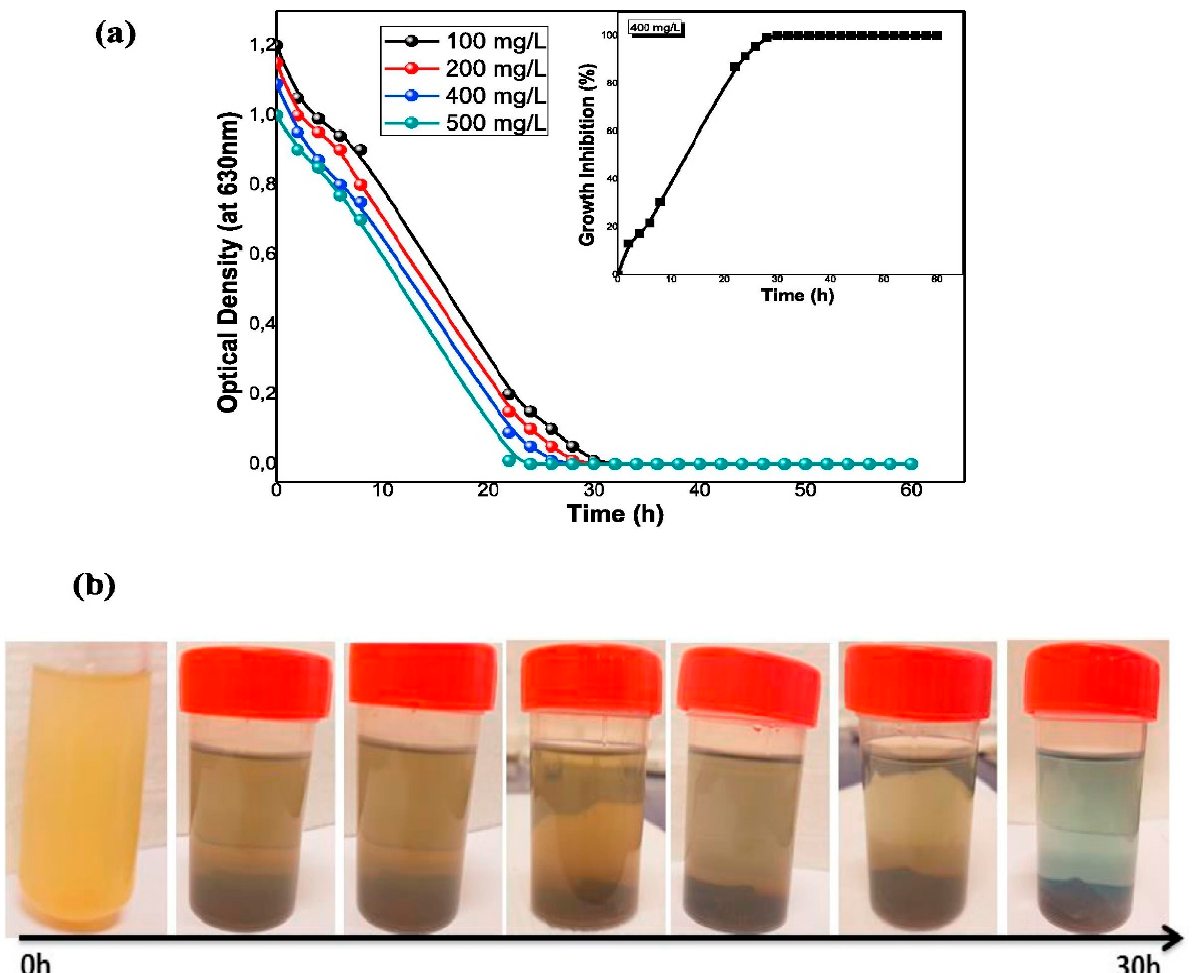
Figure 10. Optical density ( a ) and changes in the turbidity of the solution ( b ) in a cell growth inhibition experiment using INAD against a mixture of E. coli and S. epidermidis. Reprinted from [18] with permission from Elsevier.